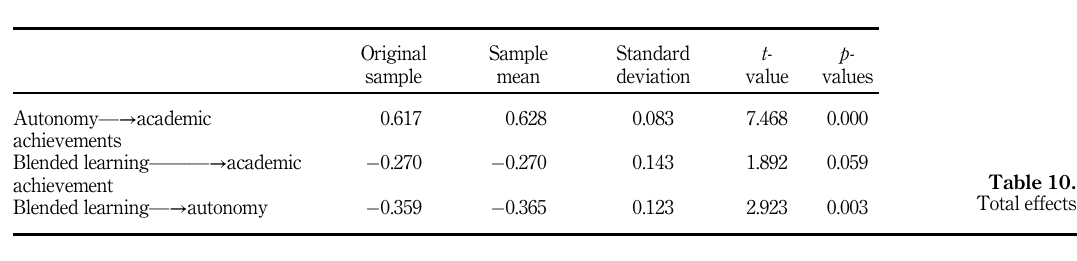
Table 9. Indirect effects